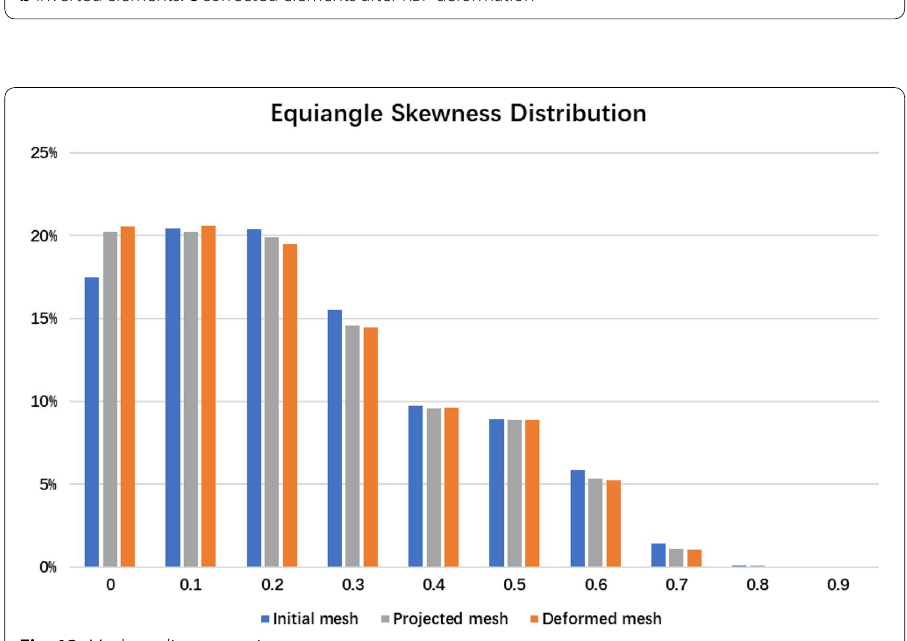
Fig. 13 Mesh quality